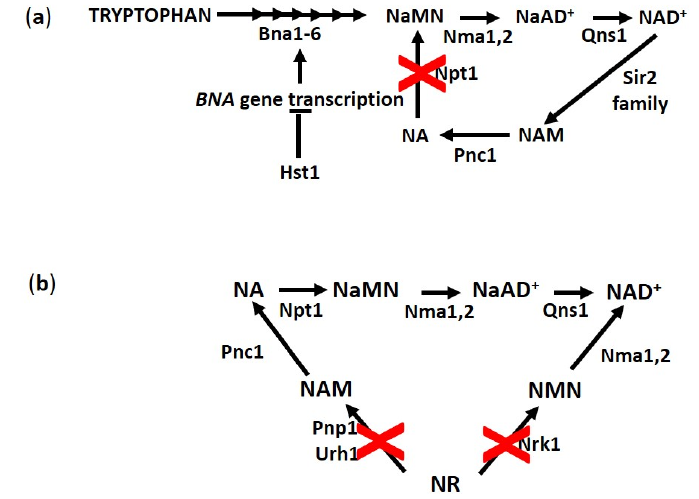
Figure 4. Scheme of main biosynthetic routes for NAD + . ( a ) Hst1 negatively controls the transcription of BNA genes required for de novo NAD + synthesis in yeast. The inactivation of NPT1 prevents NA and NAM recycling through salvage pathways. ( b ) Cells lacking Nrk1, Pnp1 and Urh1 cannot utilize NR for NAD + synthesis. Abbreviations of enzyme names are reported.